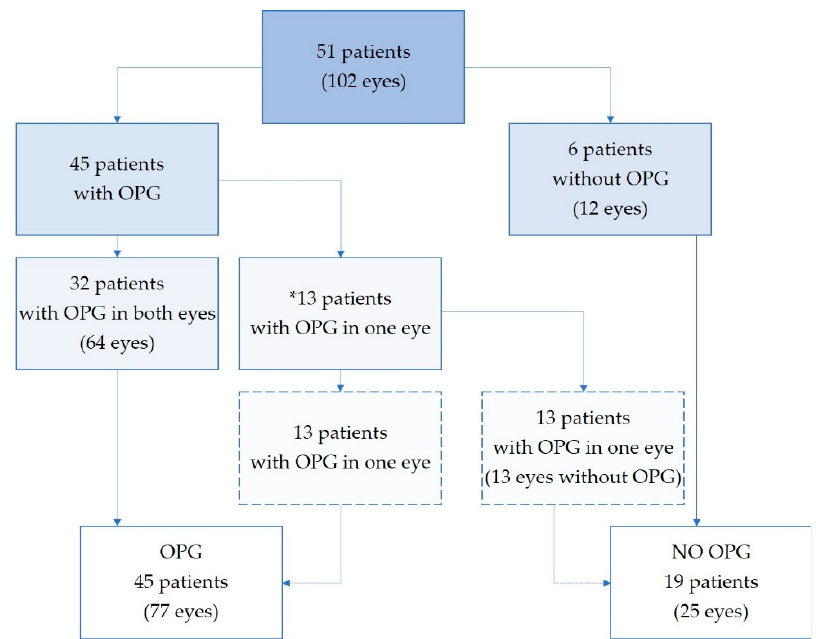
Figure 2. Study population. Eyes stratified in subgroups depending on optic pathway glioma involvement. *13 patients had strictly one-sided optic nerve glioma, leaving one eye unaffected. OPG—optic pathway glioma.